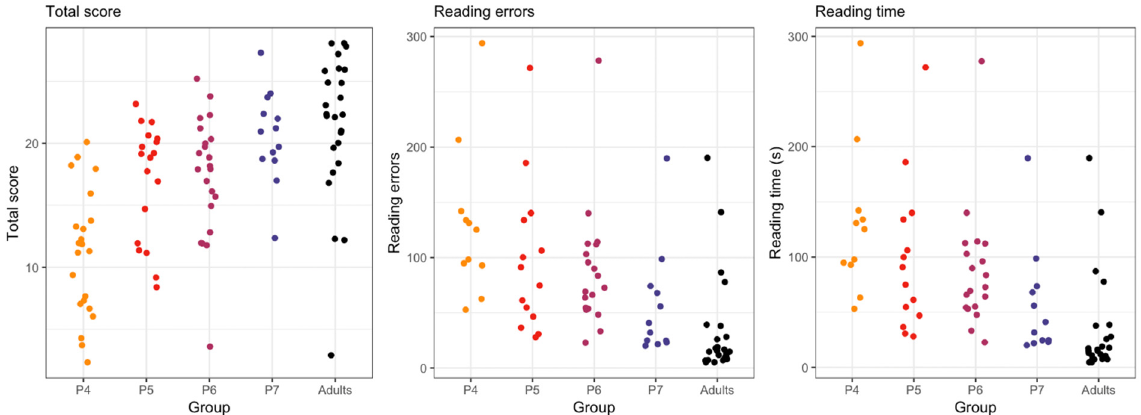
Figure 1. Scatterplot for reading test across reading dimensions: reading score, reading errors and reading times by participant groups. The reading errors and times only include participants who completed the test to give a more realistic view of the data.